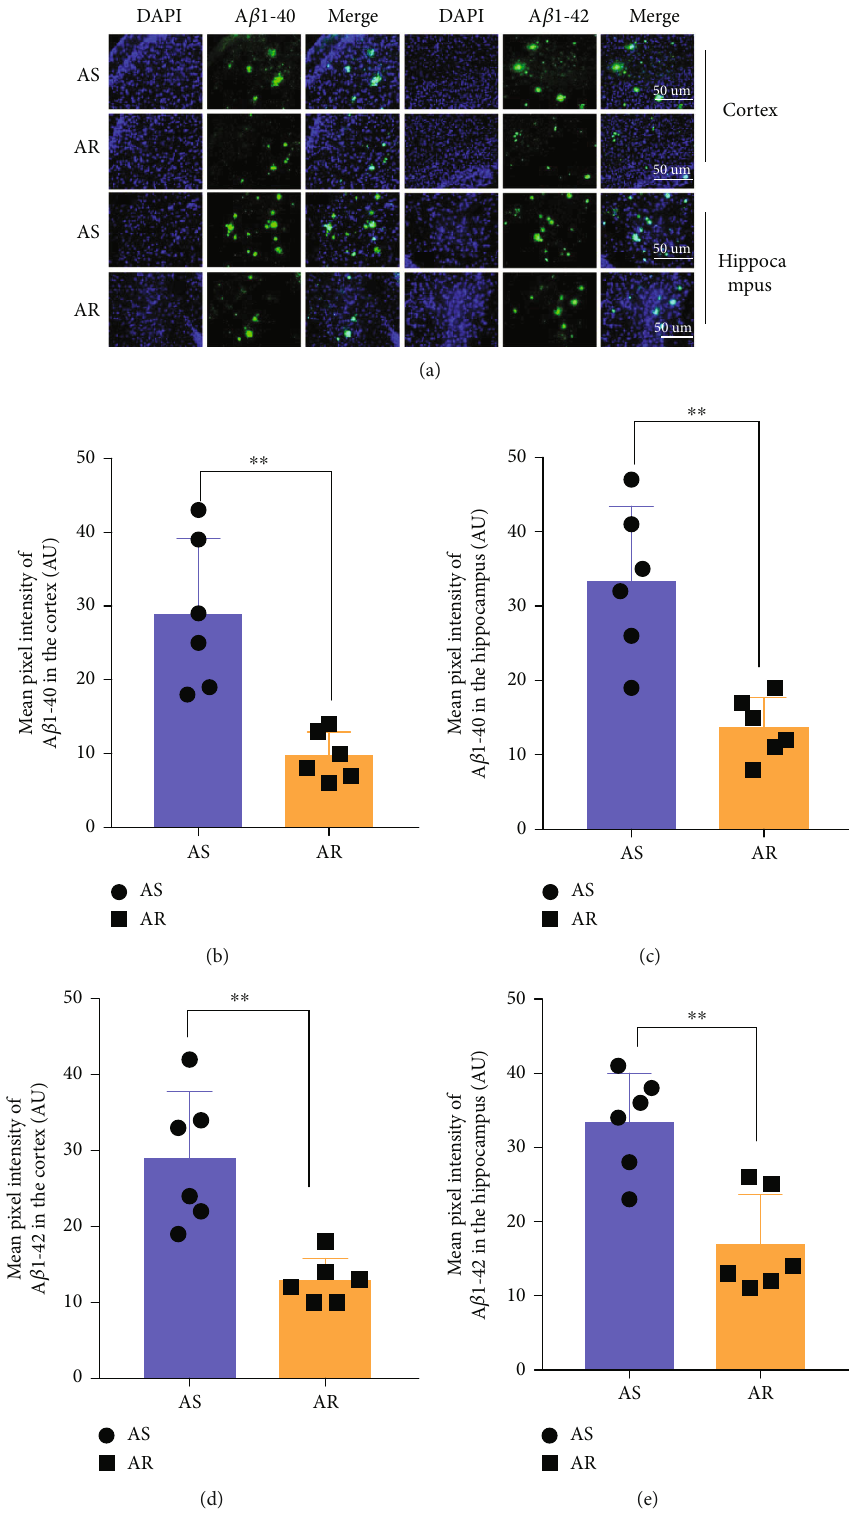
Figure 4: CTBS reduced amyloid β deposition in APP/PS1 mice. (a) Immuno fl uorescence staining of A β 1-40 or A β 1-42 in the cortex and hippocampus of AS and AR groups (400 × , scale bar: 50 μ m). (b and c) Statistical analysis of the mean pixel intensity of A β 1-40 in the cortex and hippocampus. (d and e) Statistical analysis of the mean pixel intensity of A β 1-42 in the cortex and hippocampus. Data are presented as the mean ± SD ( n = 6 mice per group, unpaired t -test for comparing two individual groups; ∗ P < 0 : 05 , ∗∗ P < 0 : 01 , ∗∗∗ P < 0 : 001 , and ∗∗∗∗ P < 0 : 0001